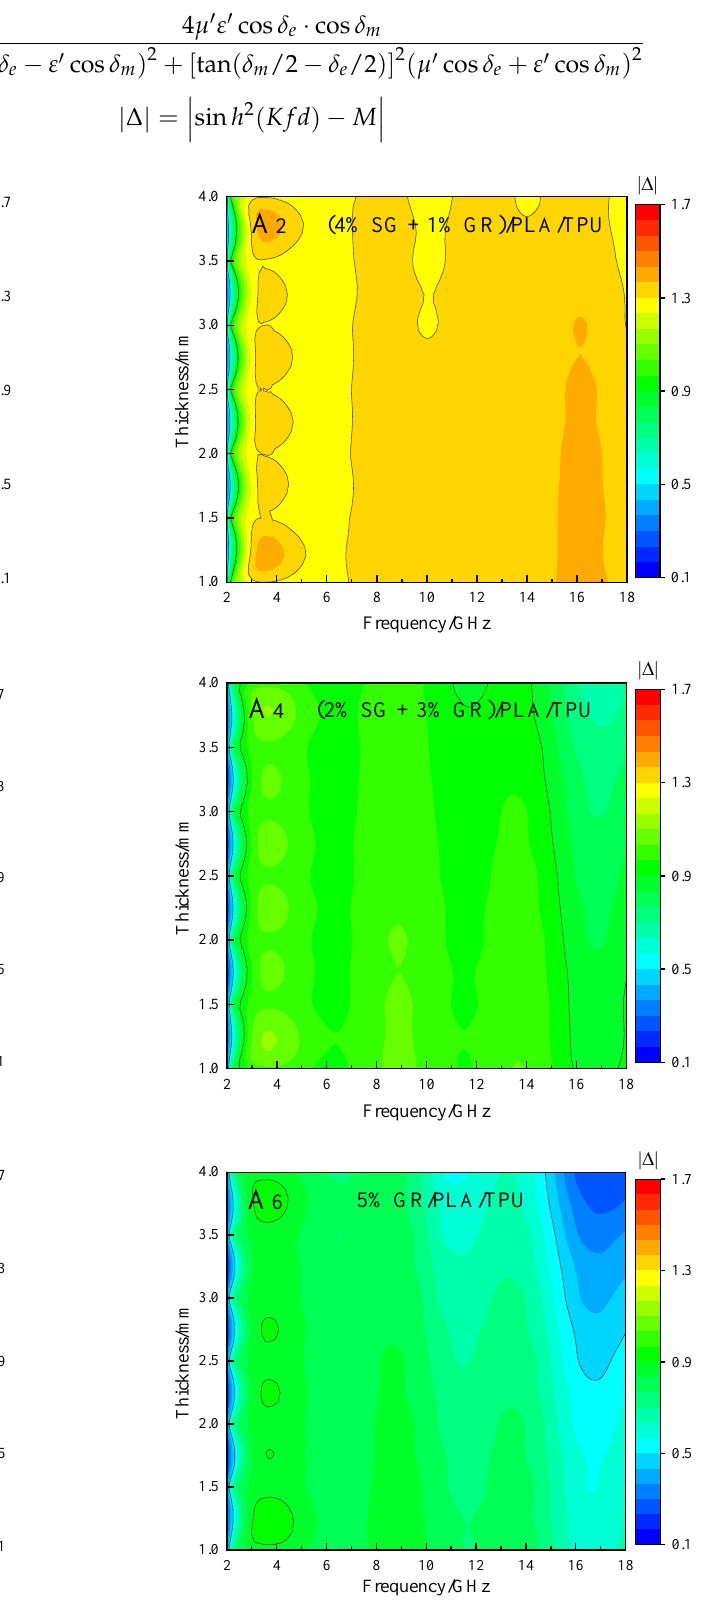
Figure 10. | Δ | value of A 1 ~A 6 composites. Figure 10. | ∆ | value of A